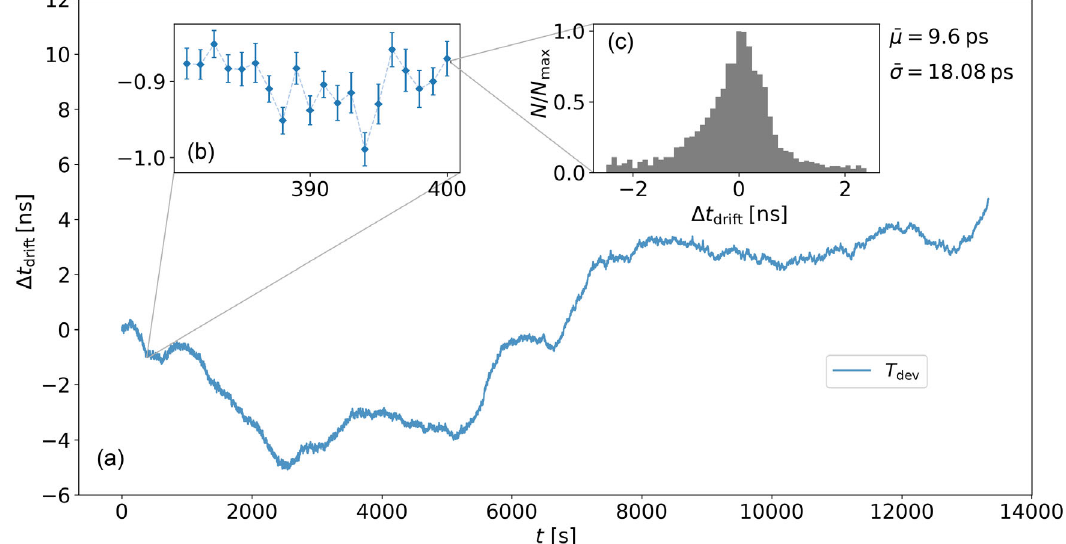
5. Clock drift. A closer look at relative clock drift T . (a) T is displayed over time in seconds from time 04 ∶ 25 onward. It dev dev shows that over a long measurement the relative drift between the Rb clocks is in the order of 10 ns. In panel (b) a 20 s interval gives a better view on the change of T per second and the residual timing error. (c) Coincidence peak for the 400th second. The dev 812 ps) of the previous second is already subtracted. That leaves a residual error of ¯ μ ¼ 9 . 6 ps to add to the accumulated offset ( Δ t off ¼